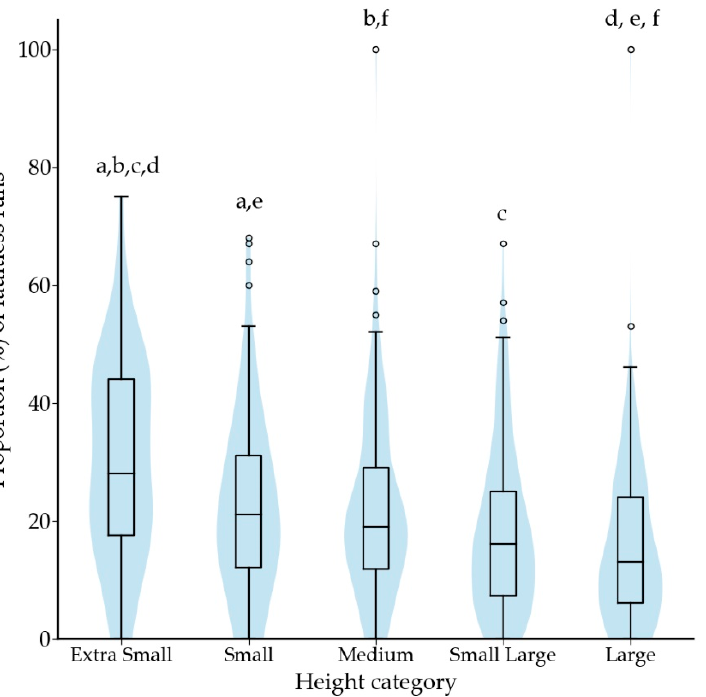
Figure 7. Proportion of faultless runs in 2018 and 2019 according to the height category. Same letter indicates significant difference between two height categories. For letters a and b, p < 0.05, and for letters c to f p < 0.001. Outliers are plotted as “ ◦ ”.